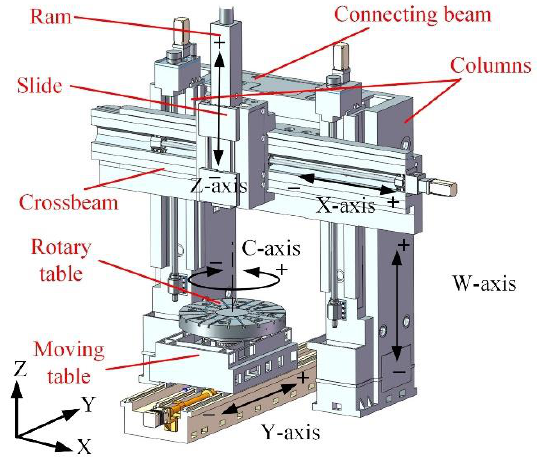
Figure 2. Schematic diagram of the structure of the HDVMC.